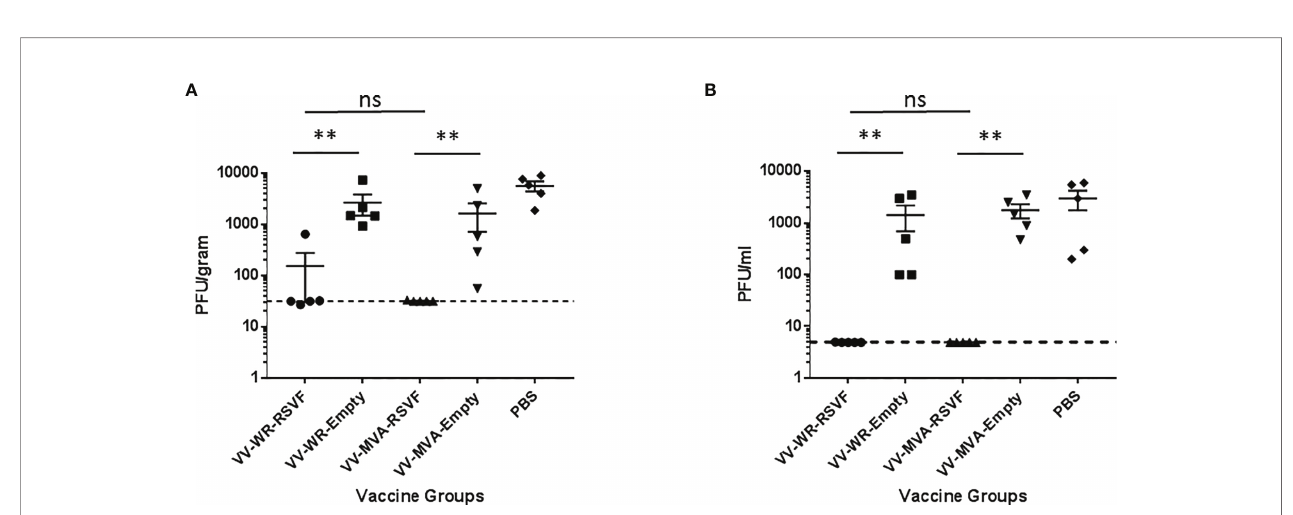
FIGURE 5 | Immunization with VV-WR-RSVF augments RSV clearance in the lower and upper respiratory tract. Cotton rats were intramuscularly immunized with one dose of 10 7 PFU of the indicated VV-WR or VV-MVA constructs and intranasally challenged with 10 6 PFU of RSV-A2 and necropsied 5 days later with n = 5 cotton rats per treatment group. (A) Lung viral titre and (B) nose viral titre (n = 5 each) were evaluated to determine viral load in the lower and upper respiratory tract respectively. **p < 0.01 (non-parametric t-test Mann-Whitney). ns, not signi fi